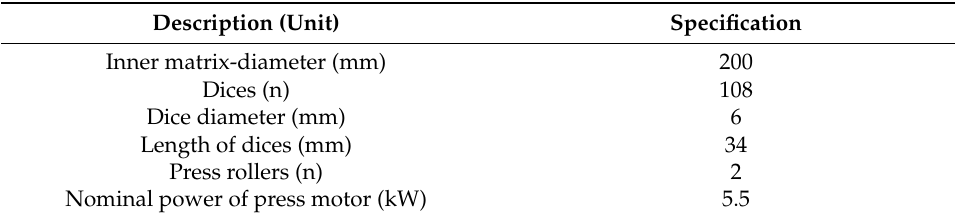
Figure 2. Pelletiser. Table 2. Specifications of pelletiser.